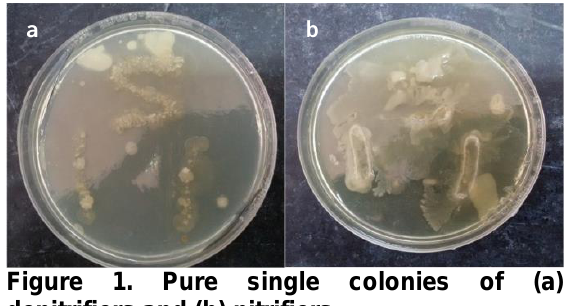
Figure 1. Pure single colonies of (a) denitrifiers and (b) nitrifiers The mixed culture of acclimatized nitrifying and denitrifying (ND) bacteria were into the two granular activated carbon submerged up-flow reactors (GAC-USRs) after 48 hours of re- acclimatization (on a rotary shaker with 140 rpm) to grow on the GAC. 21-24 Before